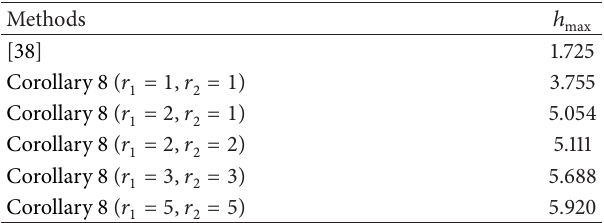
Table 2: The upper bound of ℎ max for 𝑑 = 1 and 𝛾 = 0.2